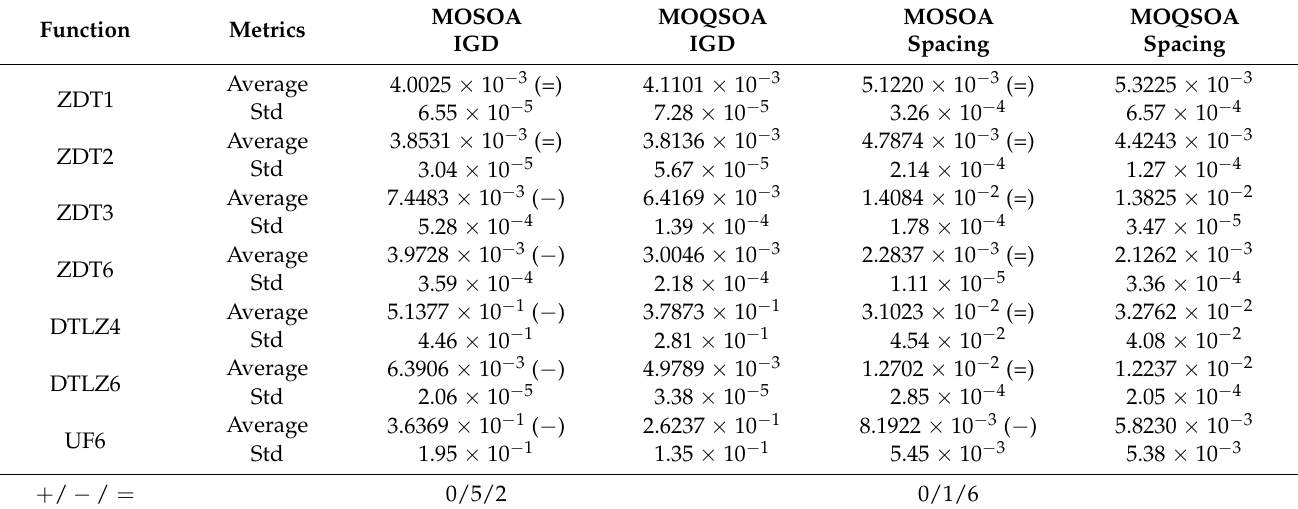
Table 5. Results influenced with real-coded quantum